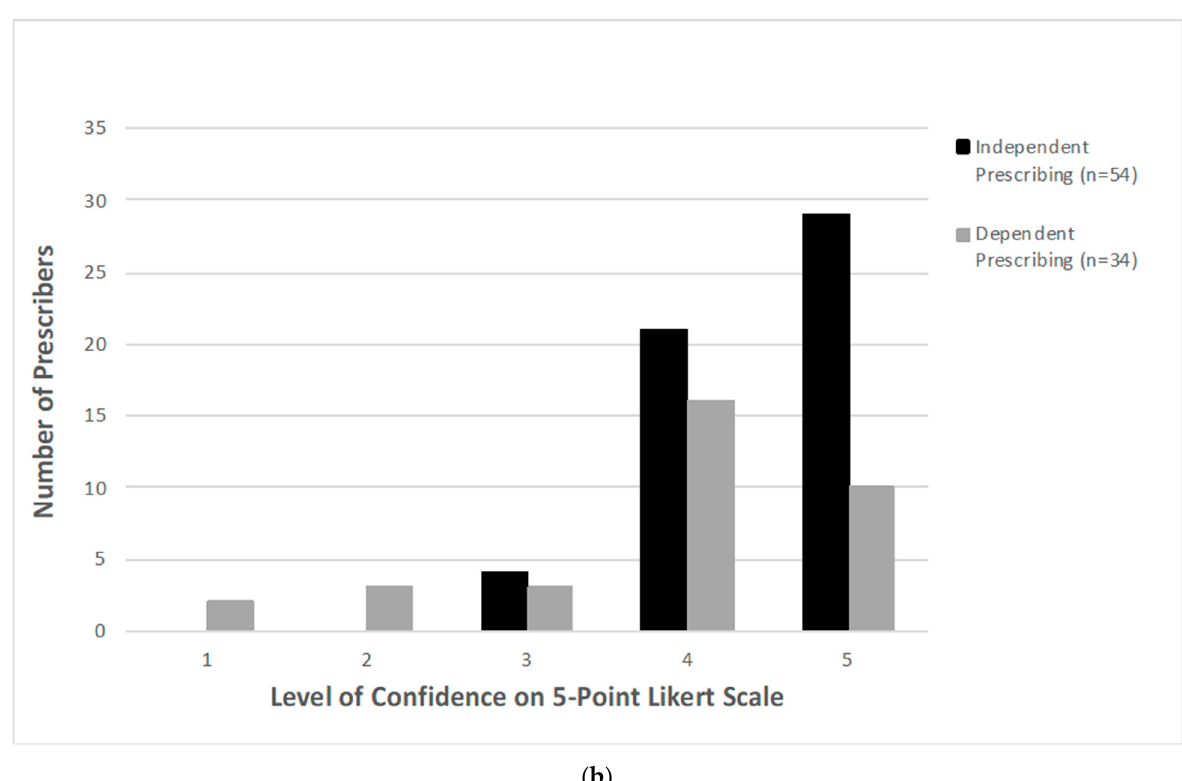
Figure 3. ( a ) Prescriber confidence if antibiotic prescription was indicated. ( b ) Prescriber confidence if antibiotic prescription was appropriate.